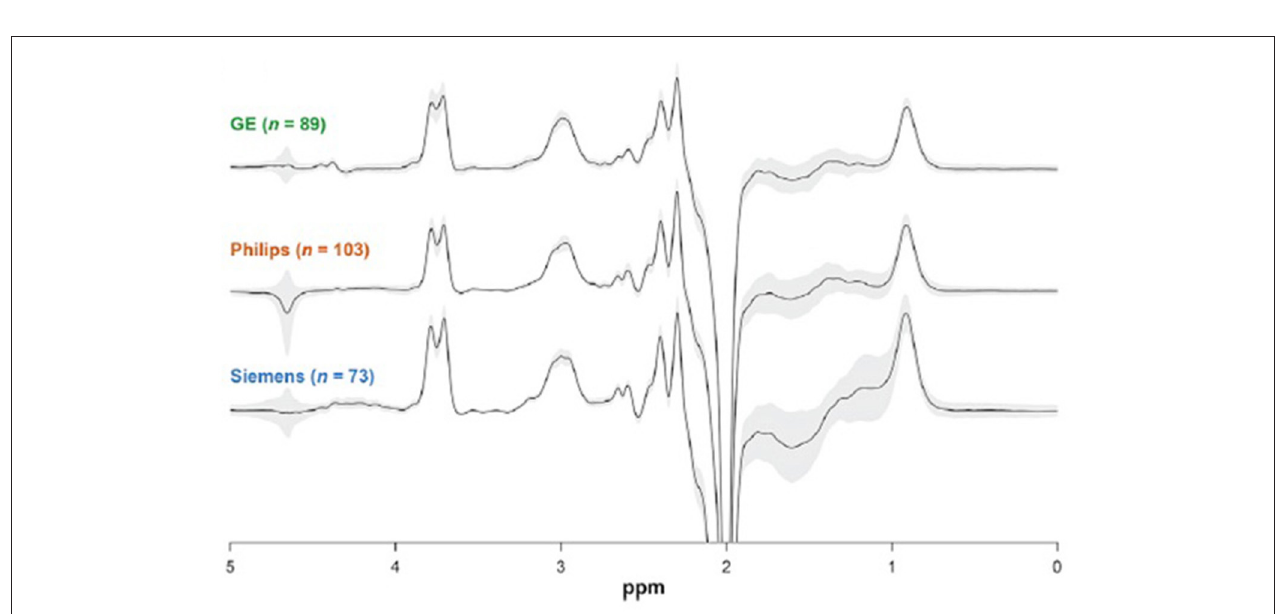
FIGURE 4 | 3.0T GABA J edited spectra of controls obtained at 24 different sites using MRI systems from 3 vendors. The similarity between the spectra explains the high reproducibility found between sites, with a 12% coefficient of variation. Each spectrum shown is the overlay of all the spectra obtained from a vendor, and demonstrates the small coefficient of variation. This figure is adapted from Figure 2 from Mikkelsen et al. (36) with